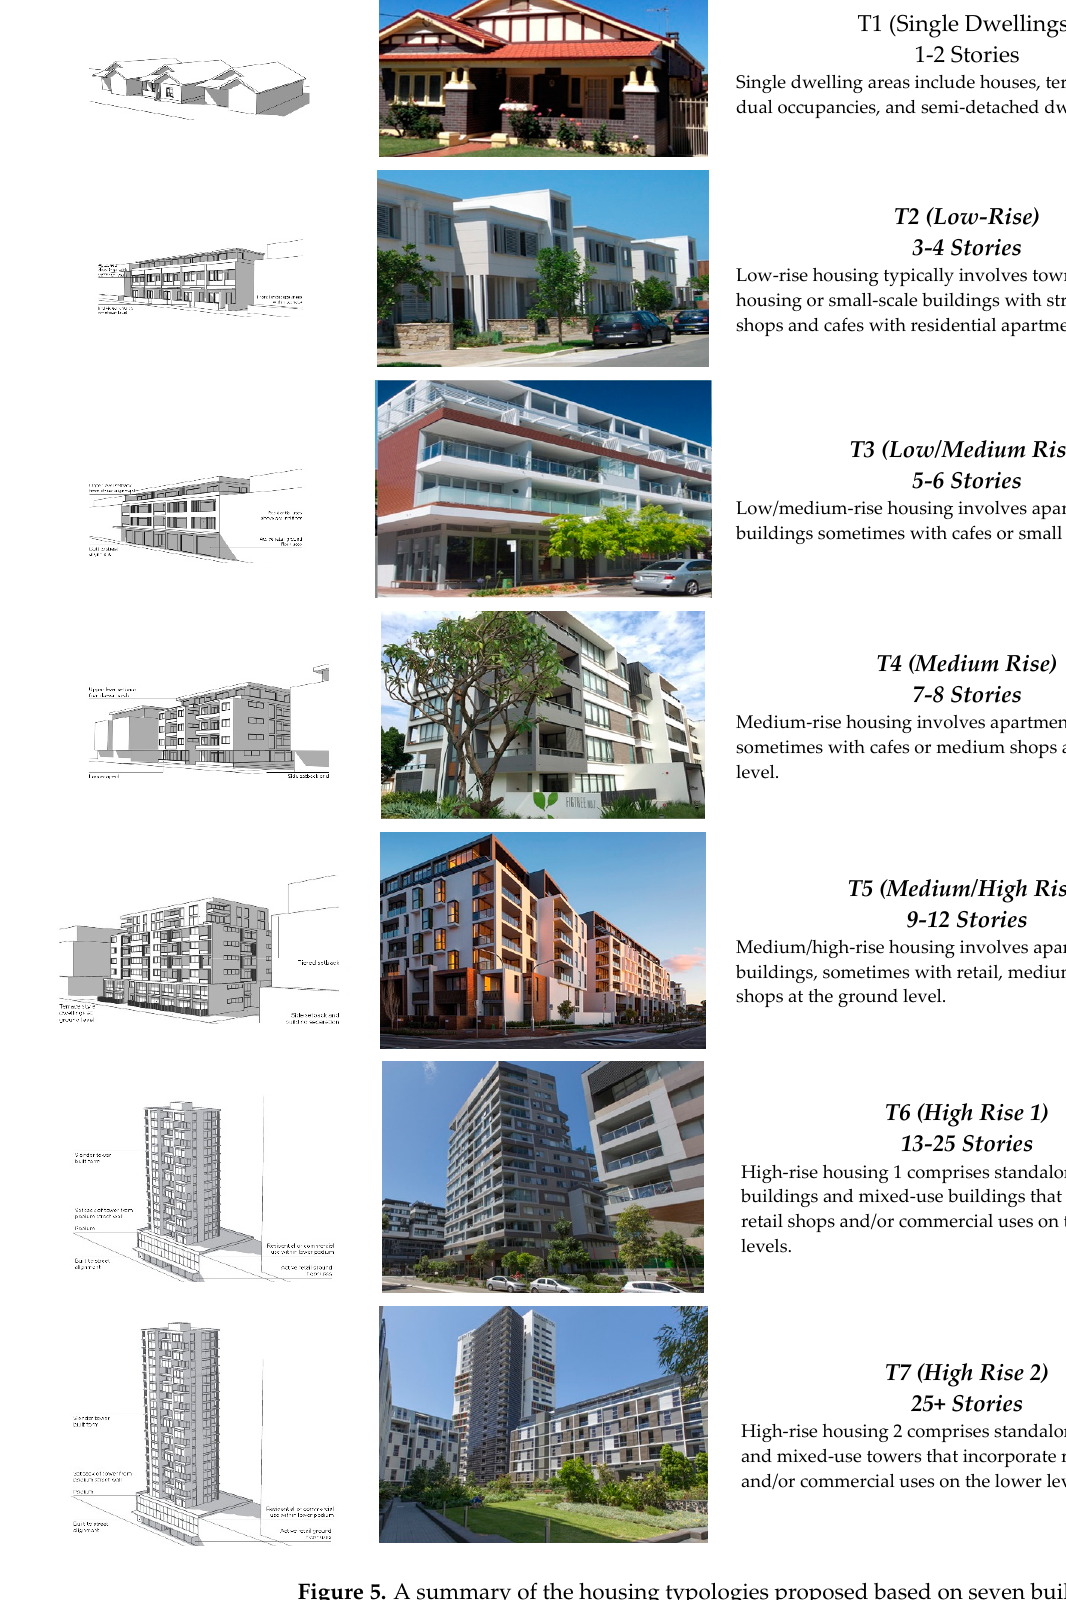
Figure 5. A summary of the housing typologies proposed based on seven building types organized in open and compact